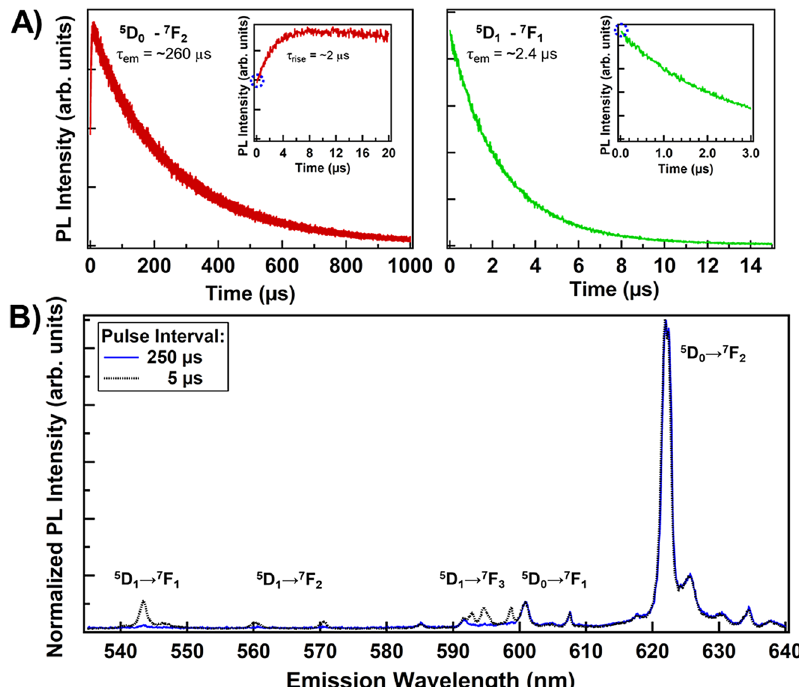
Figure 7: (A) Photoluminescence (PL) decay measurementsofthe 5 D 0 → 7 F 2 and 5 D 1 → 7 F 1 transitions. The insets show